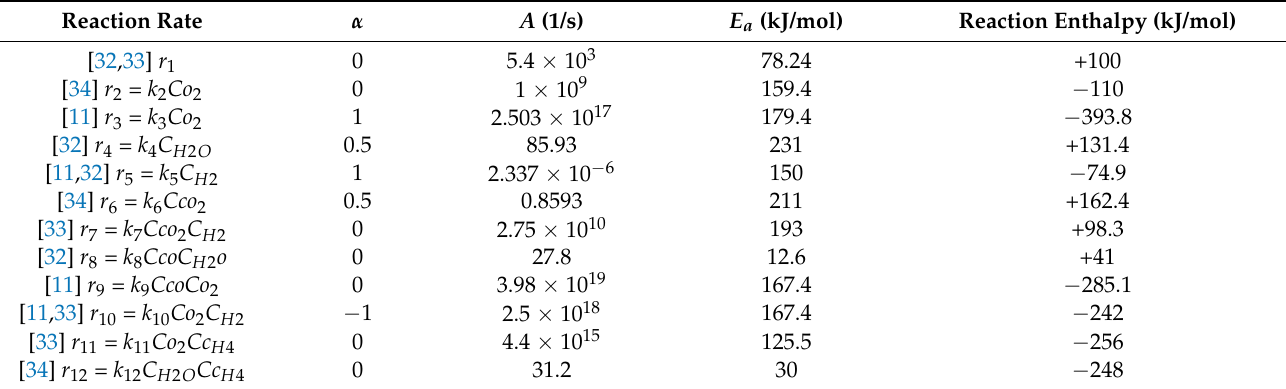
Table 1. Parameters of chemical